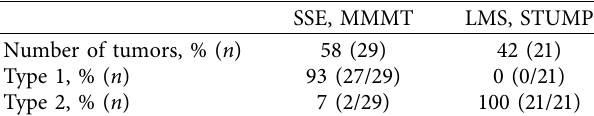
Table 1: Tumor macroscopic location within the uterus on